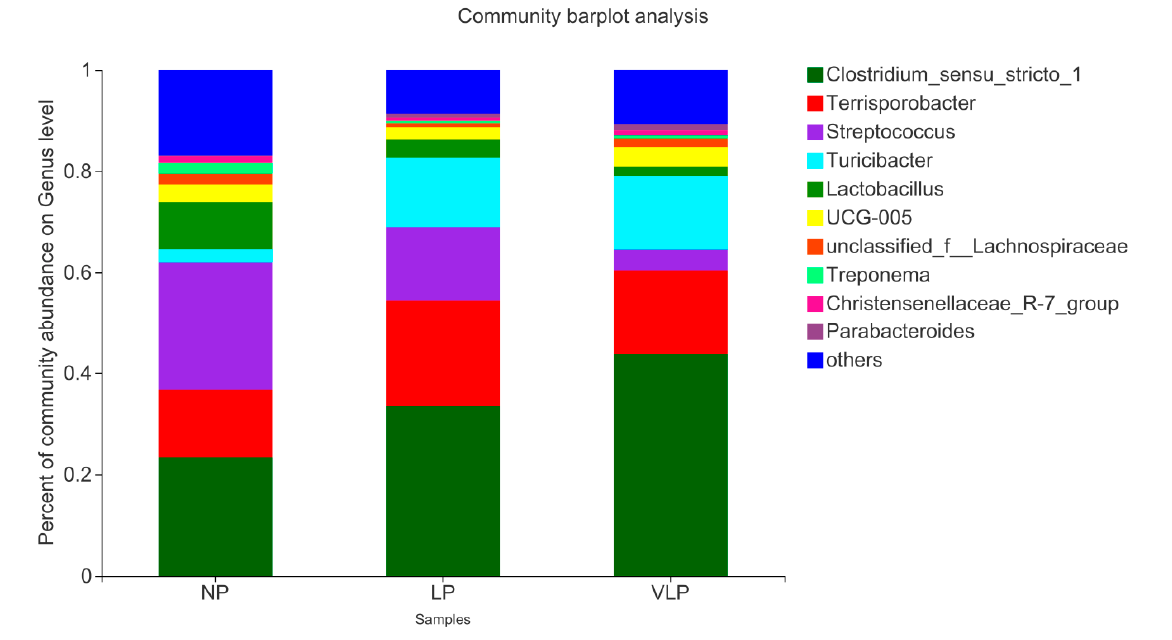
Figure 3. Relative abundance of colonic bacteria based on the genus level. The individual pig was regarded as the experimental unit ( n = 6).NP, normal protein; LP, low protein; VLP, very low pro- tein.